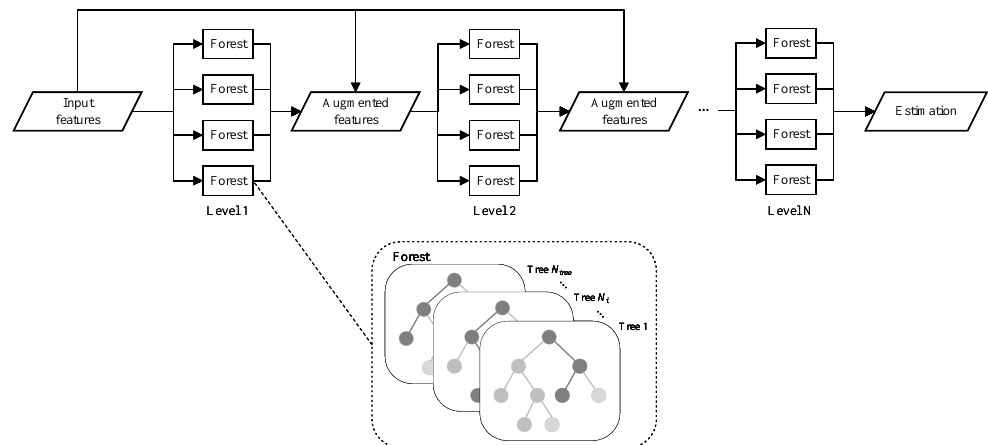
Figure 9. Illustration of the deep forest and its forest structure. Assume that there are N levels in deep forest and each level has 4 forests. The input features are fed into the first level, and each forest in the first level generates the corresponding estimations. These estimations will be concatenated with original features to compose augmented features, which are input to the next level until the final level derives the final outcome. Moreover, the structure of each forest is shown in the dashed box. A random part of input features is selected to build N tree decision trees, and the estimations generated by all trees in the same forest are averaged.